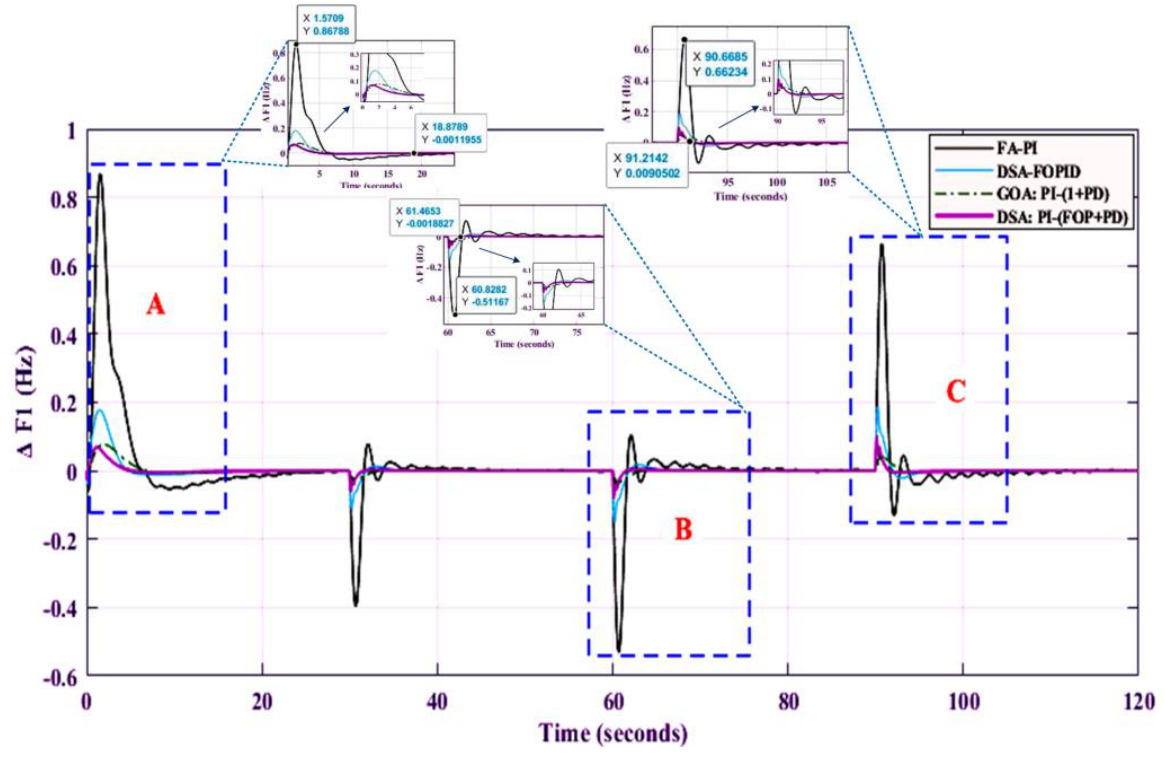
Figure 13. Area-1 frequency response.